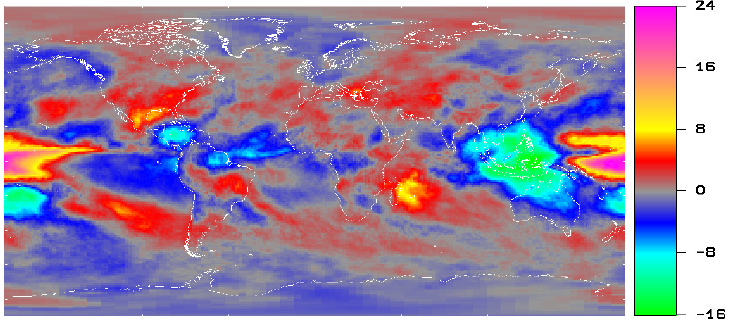
Figure 7. CERES EBAF Outgoing Longwave Radiation variability between La Nina years and El Nino years.